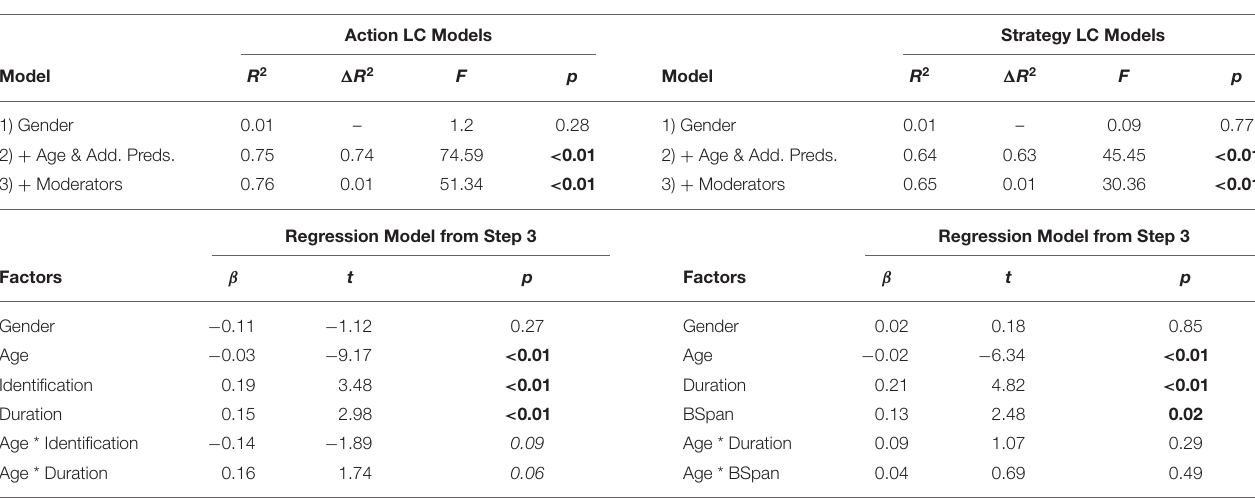
TABLE 5 | Results of moderator